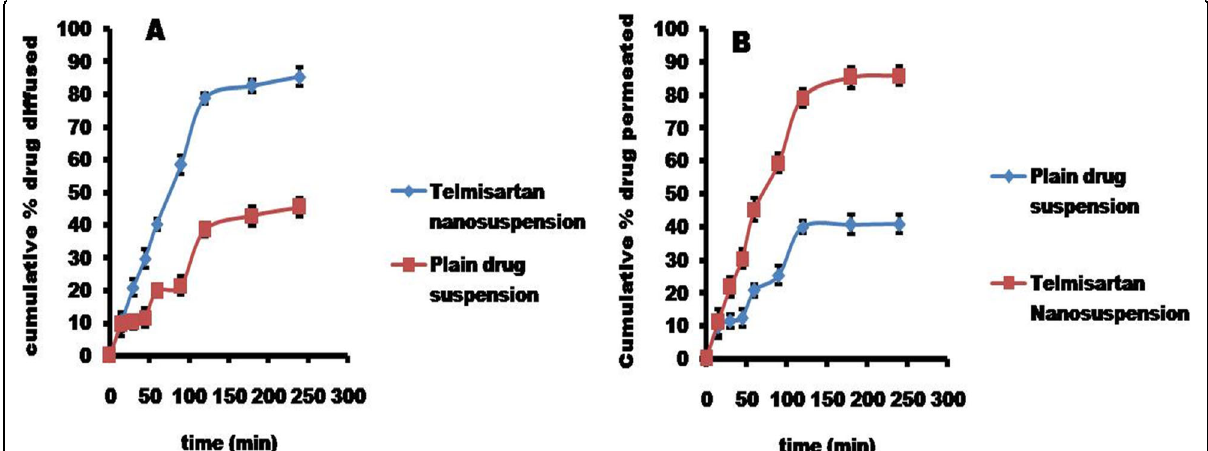
Fig. 8 Cumulative percentage drug diffused. a Ex vivo diffusion studies. b Ex vivo permeation studies. Values were expressed mean ± SD, n =